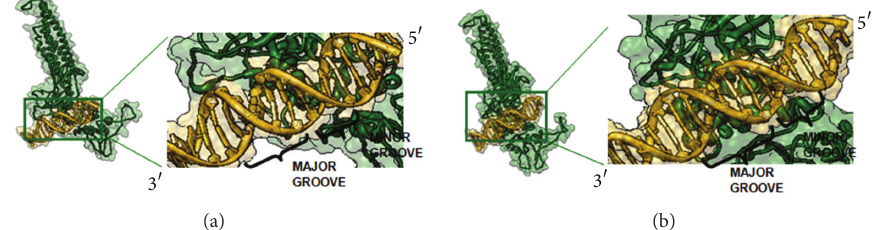
Figure 1: The differences of binding pattern in STAT3-DNA allele C (a) and STAT3-DNA allele T (b) interactions. STAT3 protein (dark green) with DNA (gold) .